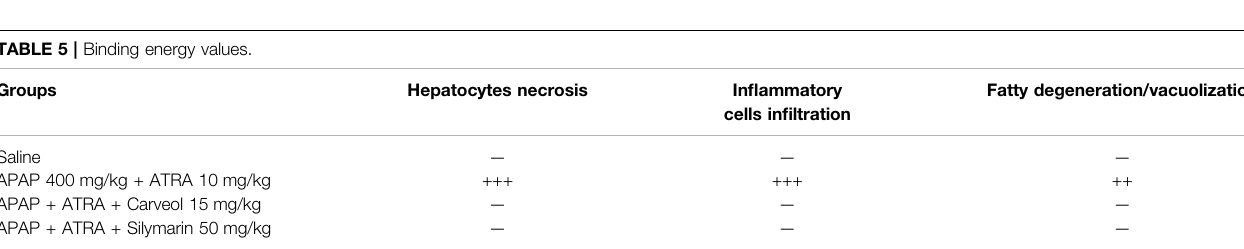
TABLE 5 | Binding energy